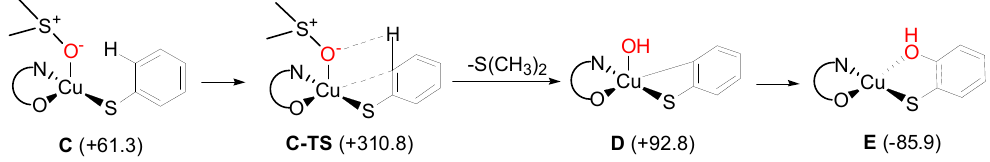
Scheme 6. Proton abstraction and hydroxyl group transfer.